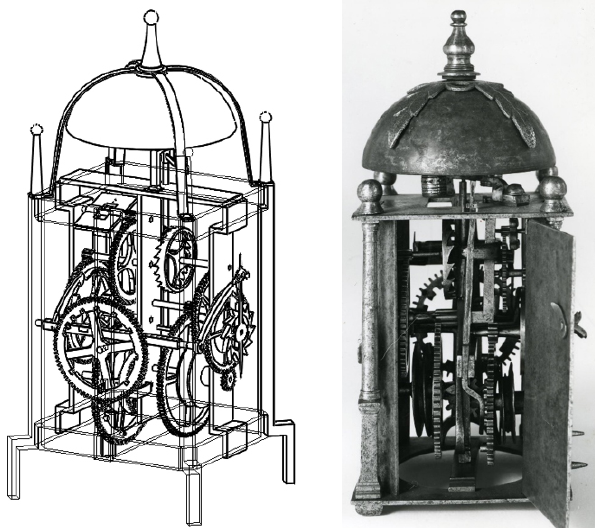
Figure 34. N14: Structure of the Italian chamber clock (British Museum, 2020b).